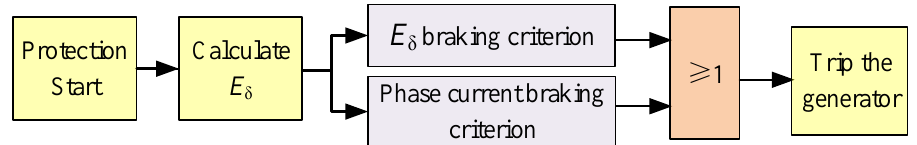
Figure 5. Logical solution of the hierarchical single transverse differential protection comprehensive criterion.